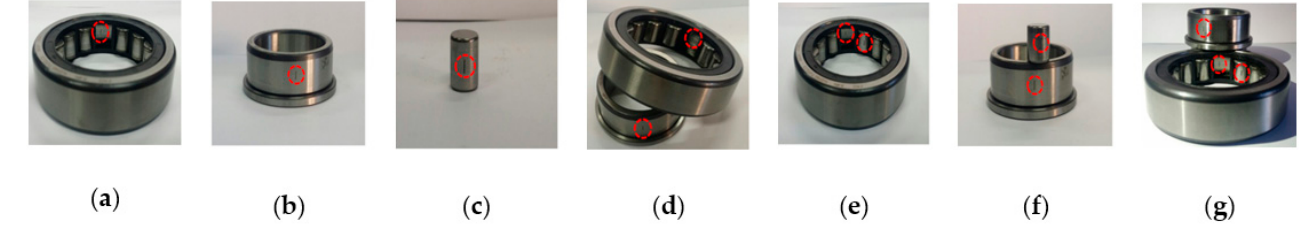
Figure 3. Seven abnormal conditions in the bearings: ( a ) OS, ( b ) IS, ( c ) BS, ( d ) IOS, ( e ) IBS, ( f ) OBS,